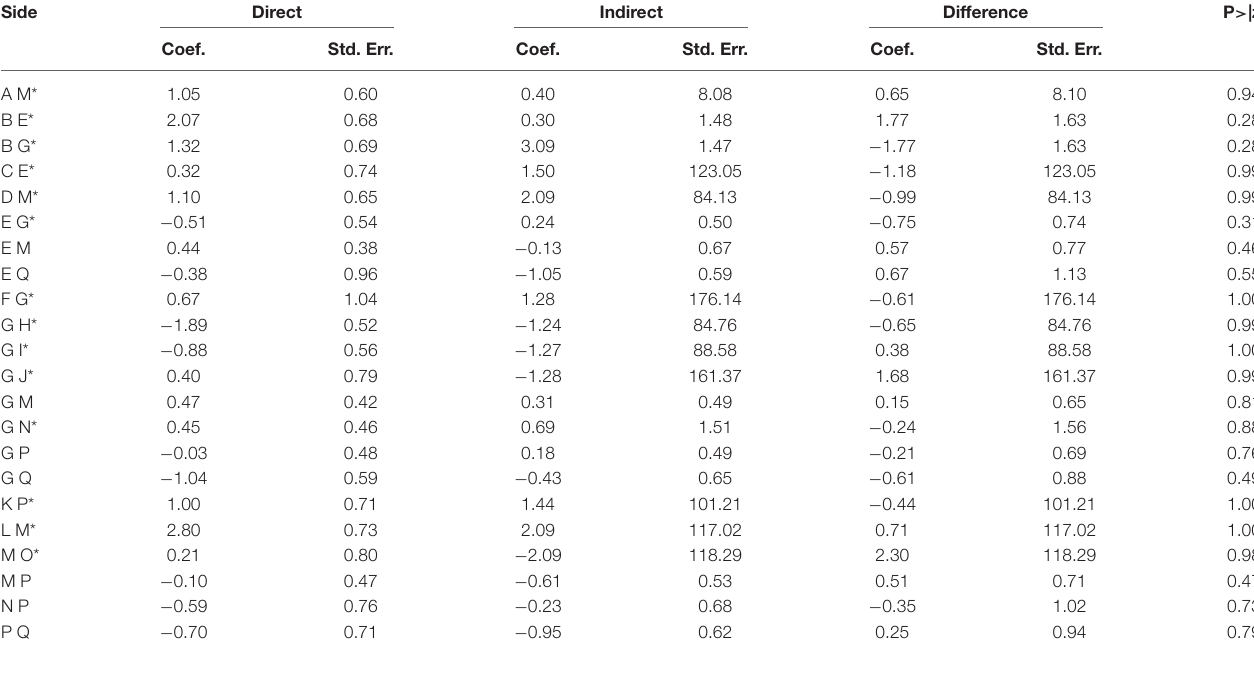
TABLE 9 | Node–splitting test for inconsistency of network meta–analysis (postoperative 24h). Side Direct Indirect Difference P > |z| Coef. Std. Err. Coef. Std. Err. Coef. Std. Err.